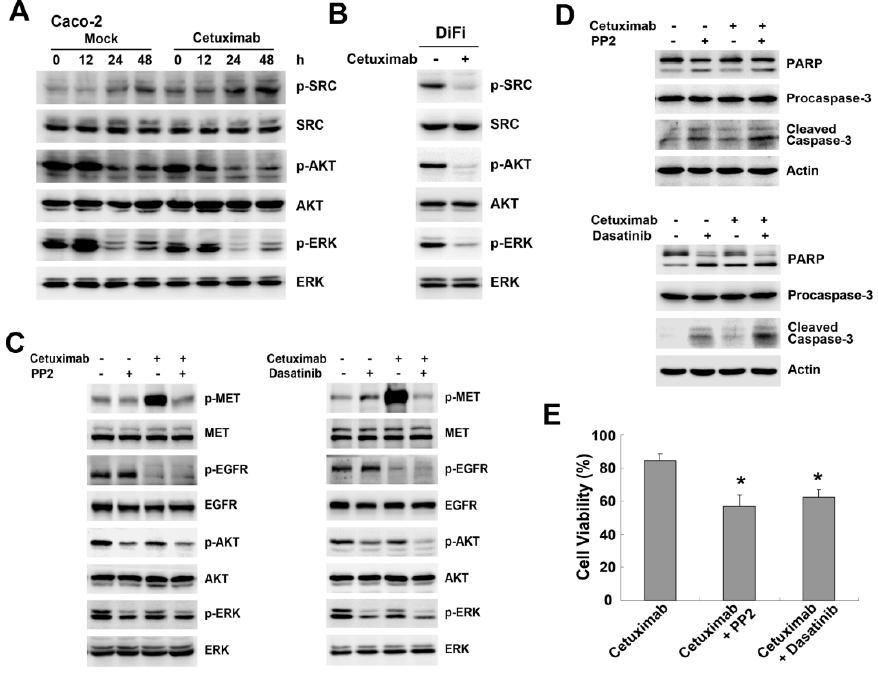
Figure 4. Role of SRC kinase in regulation of delayed MET phosphorylation. ( A , B ) Caco-2 cells and DiFi cells were treated with 10 µg/mL cetuximab for the indicated times or 48 h. Expression of SRC, AKT, ERK and phosphorylation levels were analyzed by Western blotting; ( C , D ) Caco-2 cells were pretreated with 10 µM PP2 or 0.5 µM Dasatinib for 2 h, and then treated with 10 µg/mL cetuximab for 48 h. Expression of MET, EGFR and downstream targets, and PARP and Caspase-3 were detected by Western blotting; ( E ) Caco-2 cells were pretreated with SRC inhibitors and then subjected to cetuximab for 48 h before analysis with MTT methods. The results from three independent experiments are shown. Student’s t -test, * p < 0.05 for comparisons between cetuximab-treated and combined